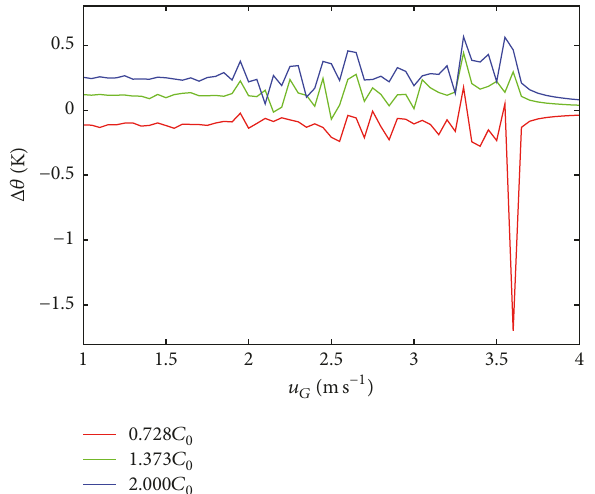
Figure 4: Temperature difference between the scenarios with CO 2 concentrations (indicated by the legend), in relation to the actual carbon dioxide concentration in the connected state.